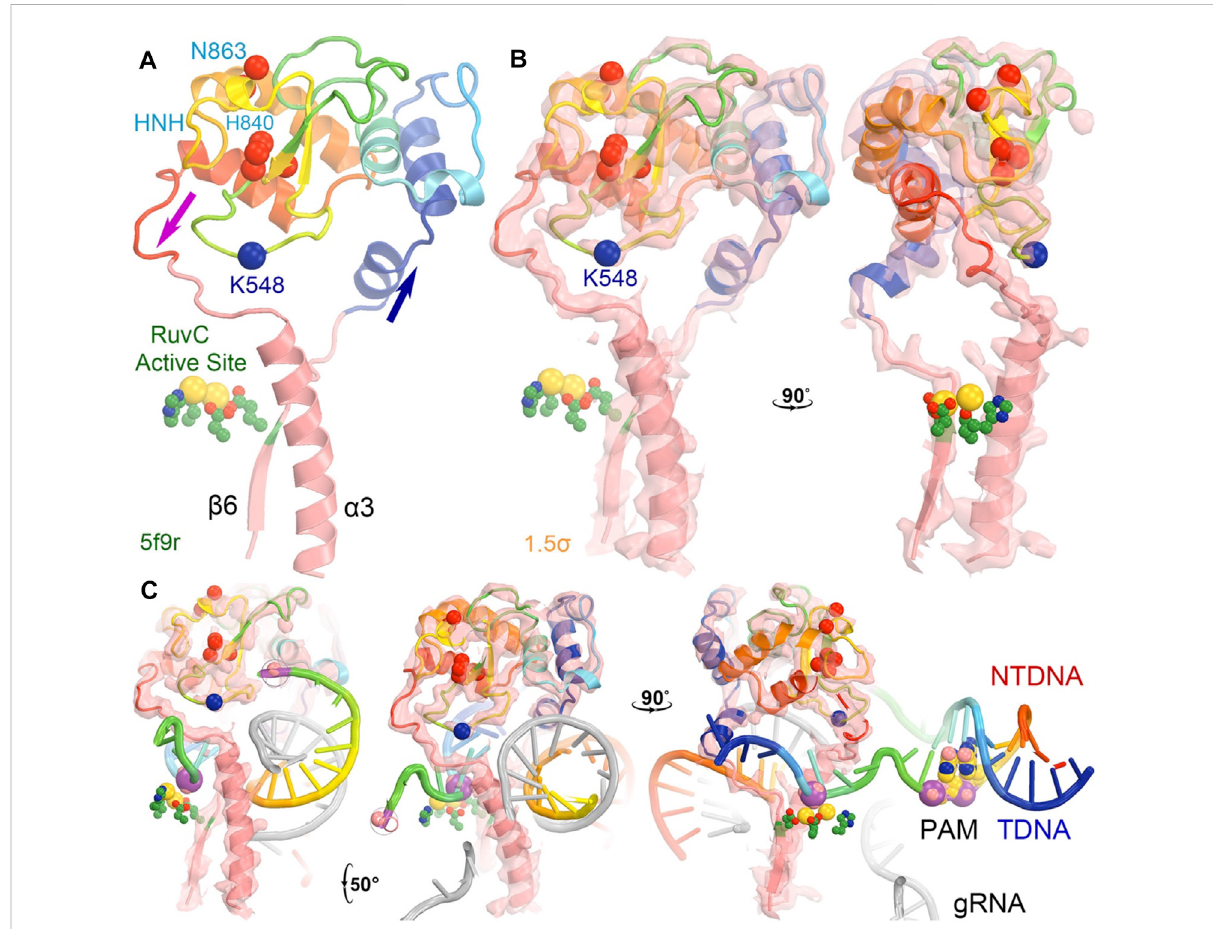
FIGURE 6 TheHNHdomainservesasapartoftheRuvCactivesiteinthe5f9rstructure. (A) TheHNHdomainisinsertedbetweenthe β 6standand α 3helix near theRuvC active site (green side chains plus two modeled Mg ions ingold). The location ofK548(which was built as an alanine residue as well as many other residues also as alanine residues including K510 and some HNH catalytic residues). (B) Two orthogonal views of σ A -weighted F o – F c ED mapsretrievedfromthePDBcontouredat+1.5 σ . (C)